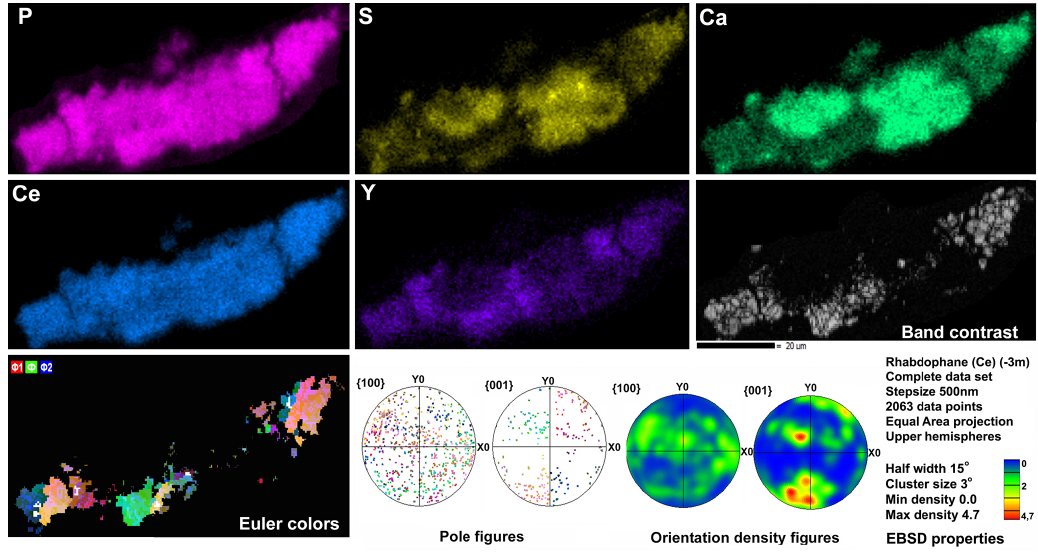
Figure 8. Distribution of elements, EBSD band contrast, rhabdophane crystal orientation in Euler colors. pole figures (each point in the pole figures corresponds to one point in the rhabdophane crystal orientation map and retains its color) and orientation distribution density heatmaps of rhabdophane aggregate with four spherical growth centers; for BSE image, see Fig. 3c.